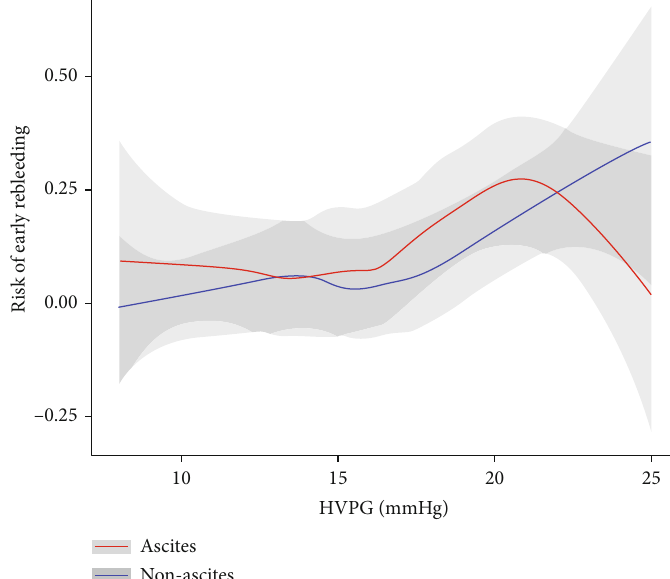
Figure 3: LOWESS curve for assessing the trend of risk for early rebleeding on HVPG in the ascites cohort and nonascites